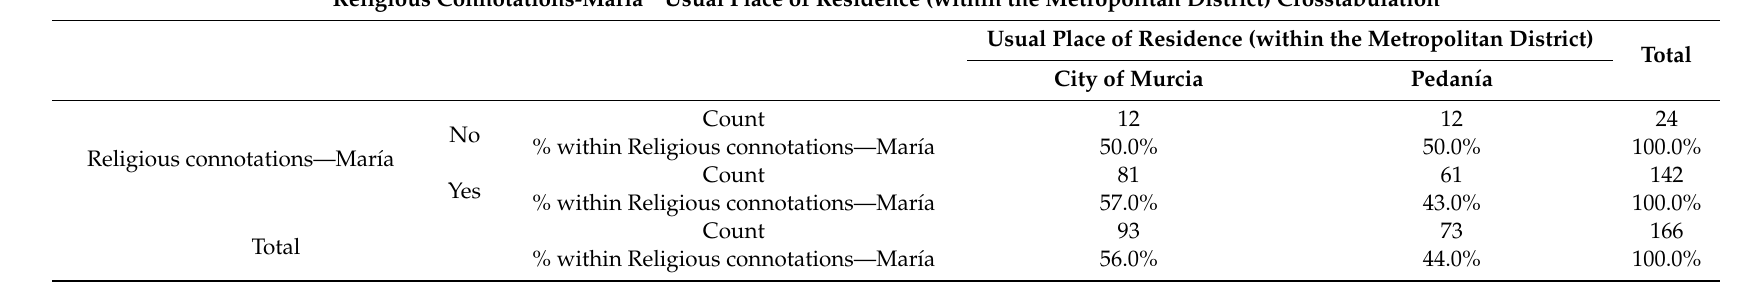
Table 10. Religious connotations in terms of usual place of residence for the name Mar í a in the metropolitan district of Murcia. Religious Connotations-Mar í a * Usual Place of Residence (within the Metropolitan District) Crosstabulation